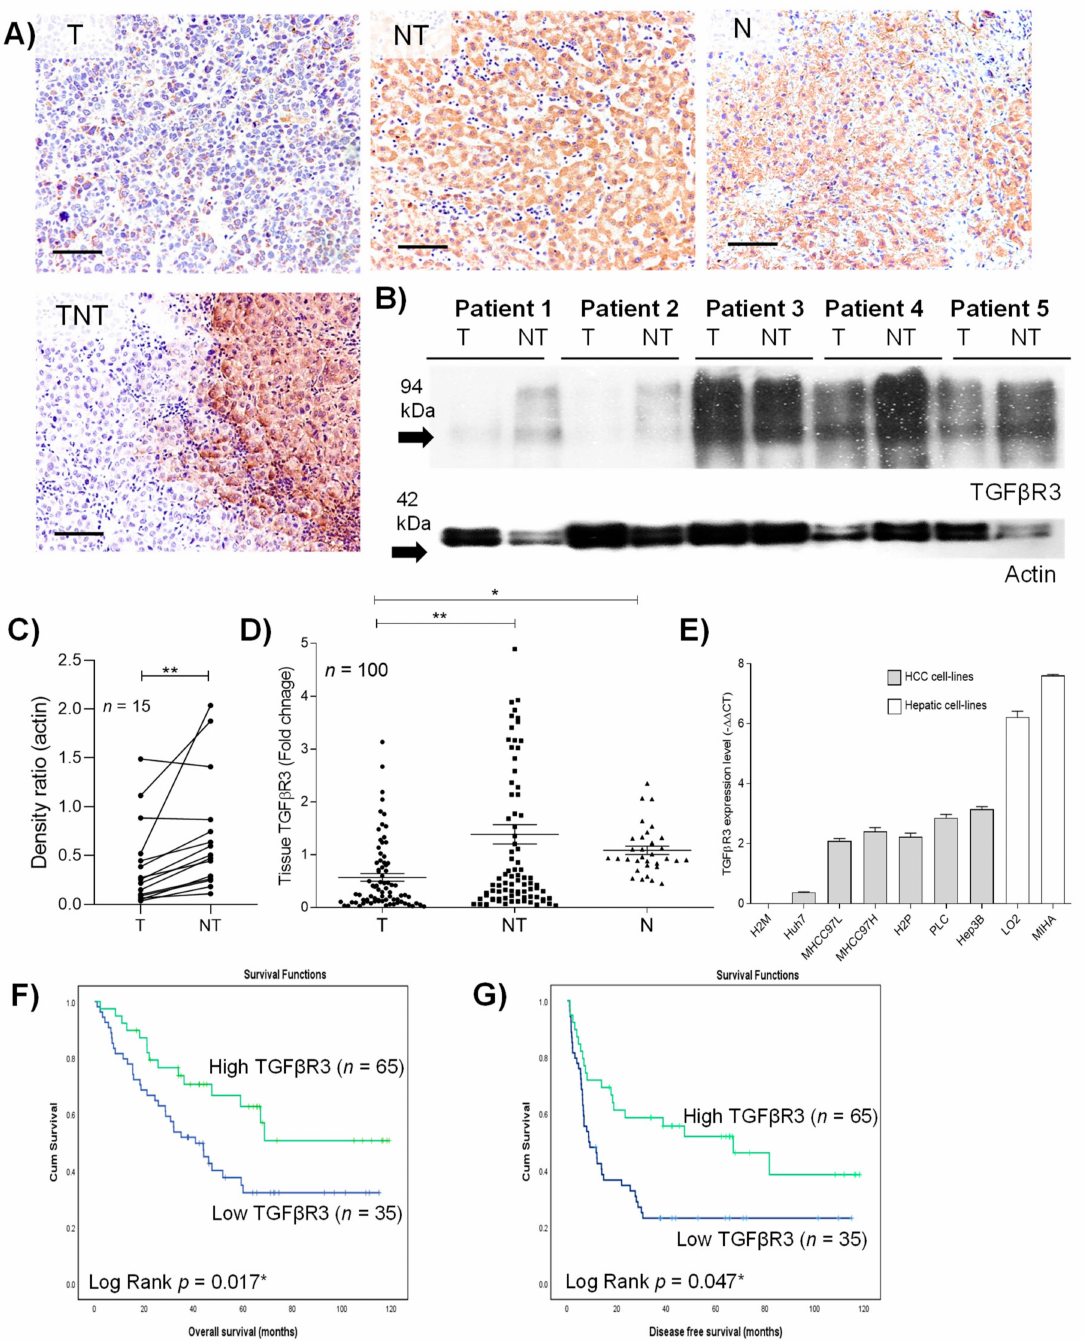
Figure 1. Clinical characteristics of transforming growth factor beta type III receptor (TGF β R3) in hepatocellular carcinoma (HCC) tumoral tissue. ( A ) Representative image of immunohistochemical staining of TGF β R3. ( B ) Western blotting analysis of the protein level of TGF β R3. ( C ) Densitometric quantification of Western blotting relative to actin. ( D ) Quantitative-PCR analysis of transcript level of TGF β R3. ( E ) Transcript analysis of TGF β R3 in hepatocyte and HCC cell-lines. Kaplan–Meier analysis of ( F ) overall survival and ( G ) disease-free survival in HCC patients associated with the expression level of tumoral TGF β R3 transcript. T: tumor, NT: tumor-adjacent non-tumor, N: normal liver, TNT: intra- and peri-tumor; Scale bar: 50 µ m; * p < 0.05, ** p < 0.01. Error bar indicated SEM. (Unpaired t -test for Figure 1C,D) (Paired t -test for Figure 1E) (Log rank test for Figure